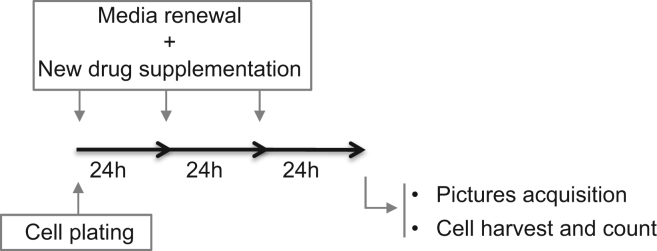
Experimental design.